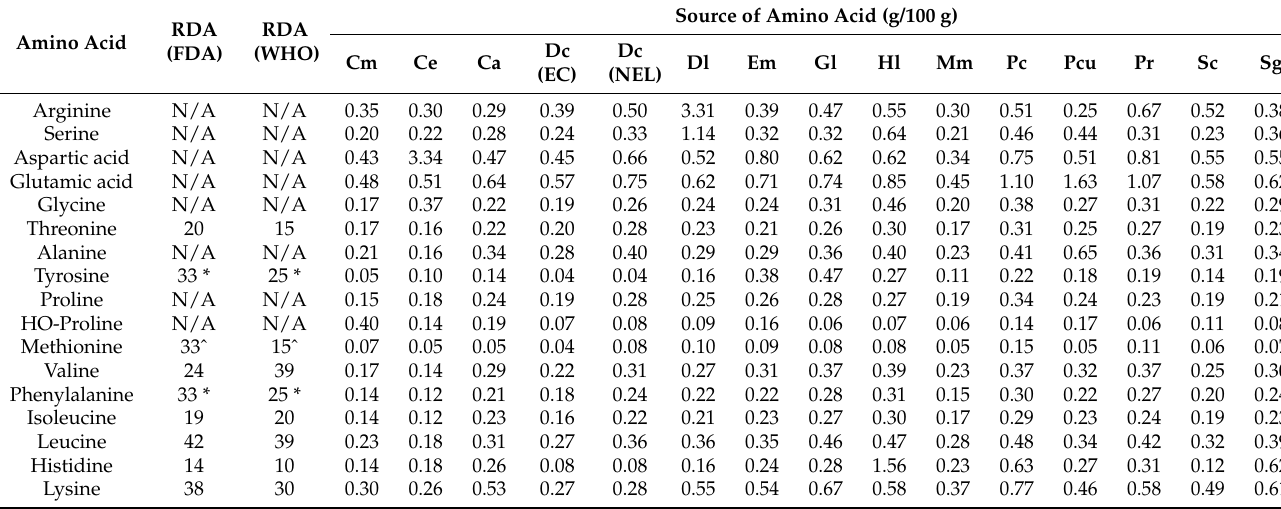
Table 4. List of wild indigenous fruit plants, amino acids composition, and RDA values for indispensable amino acids. Amino